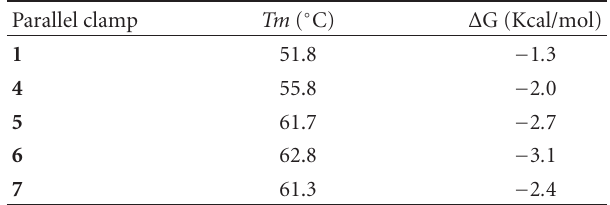
Table 2: Melting temperature ( Tm ) and free energies of the parallel duplex-to-random-coil transition. a